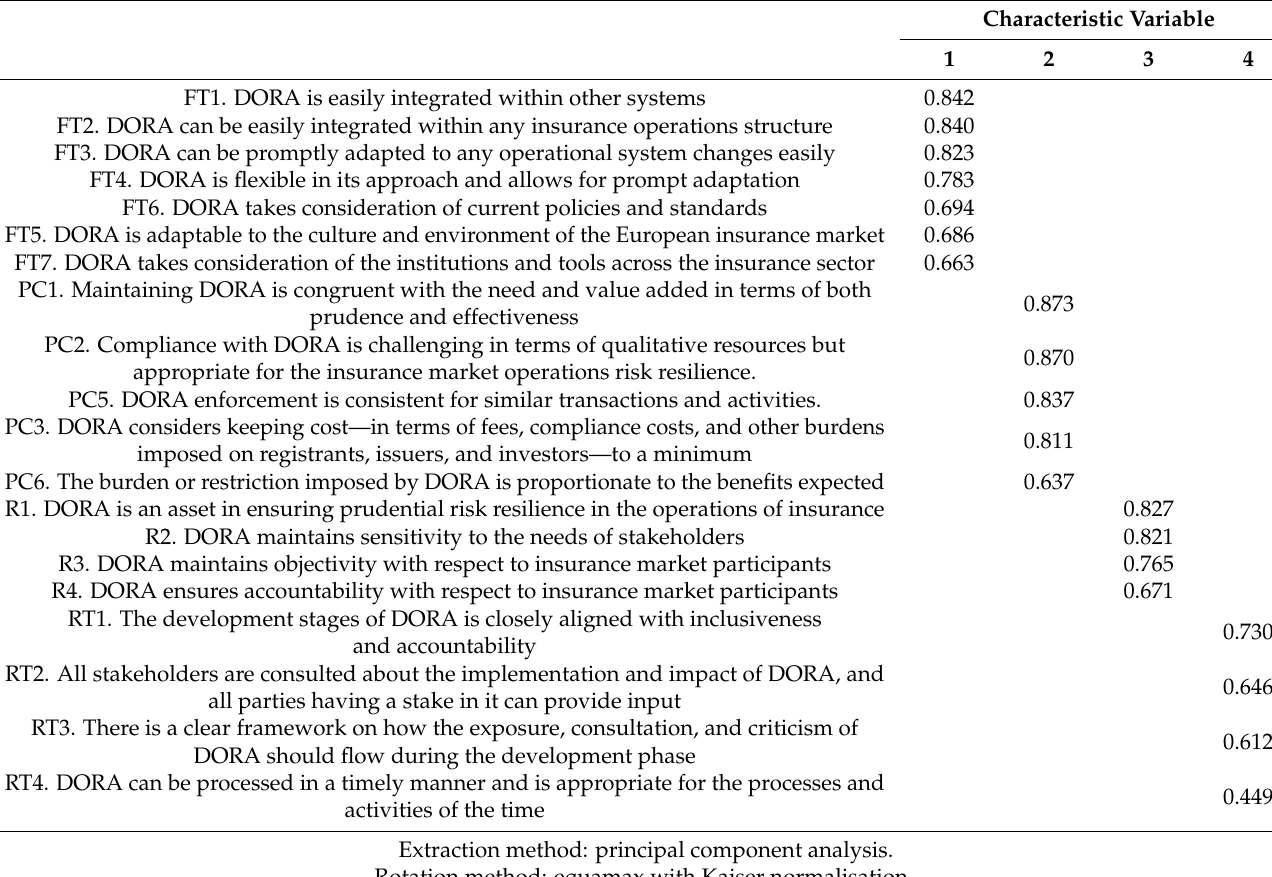
Table 2. Exploratory factor analysis a